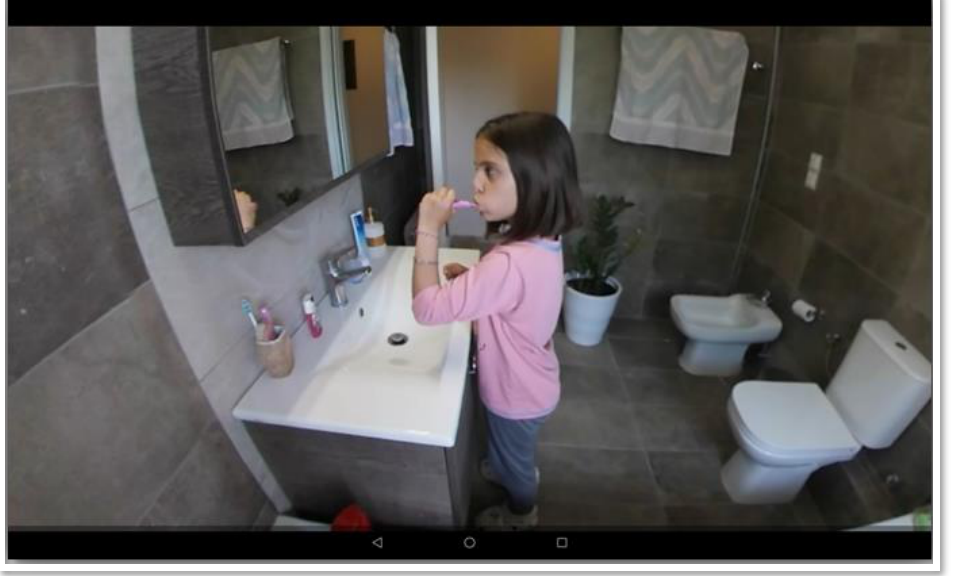
Figure 29. Overlay after brushing teeth trigger recognition (AR